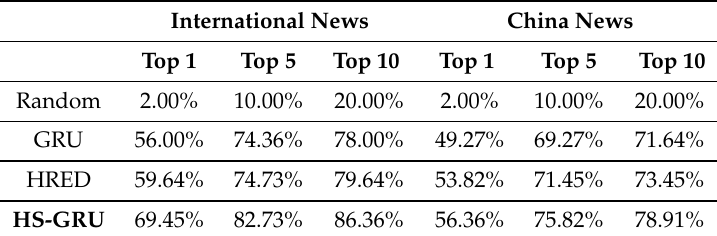
Table 5. The result of event selection task on two